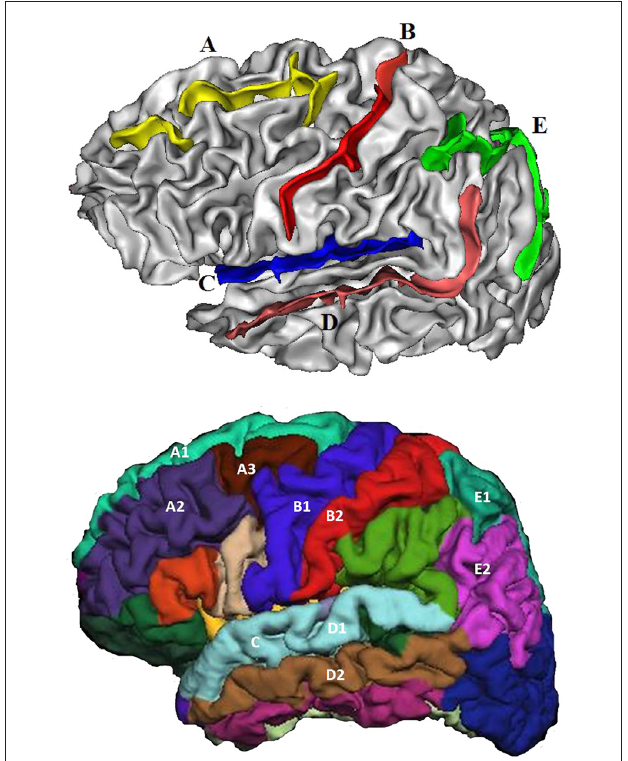
FIGURE 2 | The five sulci and adjoining gyri selected for investigation. Top: (A) Superior frontal sulcus, (B) Central sulcus, (C) Lateral sulcus, (D) Superior temporal sulcus, and (E) Intra-parietal sulcus. Bottom: Superior frontal sulcus: superior frontal (A1) , middle frontal (A2) + (A3) . Central sulcus: pre-central (B1) , post-central (B2) . Lateral sulcus: superior temporal (C) . Superior temporal sulcus: superior temporal (D1) , middle temporal (D2) . Intra-parietal sulcus: superior parietal (E1) , inferior parietal (E2) .